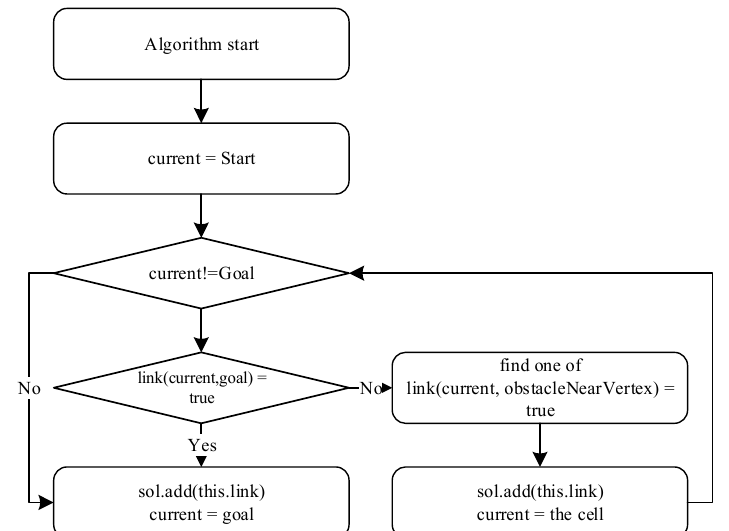
Figure 8. The flowchart of ‘makeSol’ logic.